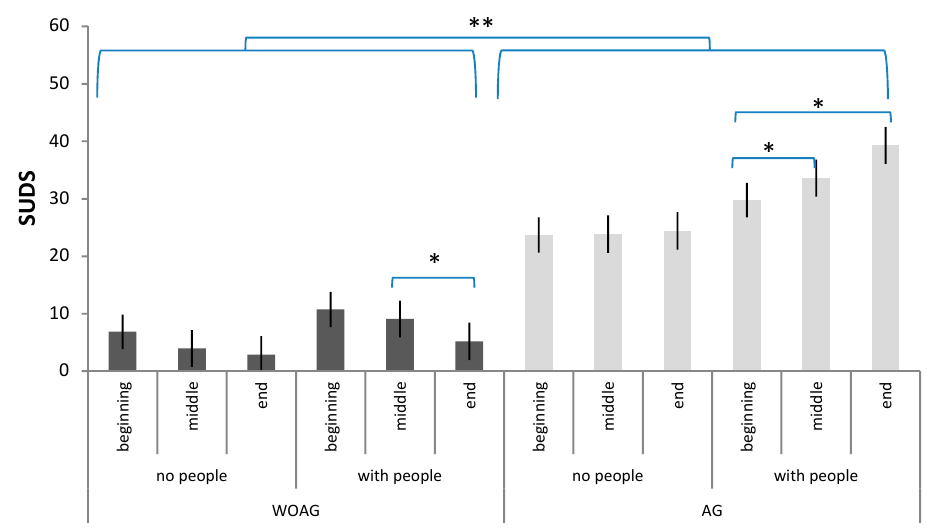
Figure 4. Means and standard deviations for the group x period x scenario interaction. * p < 0.05 ** p < 0.001.